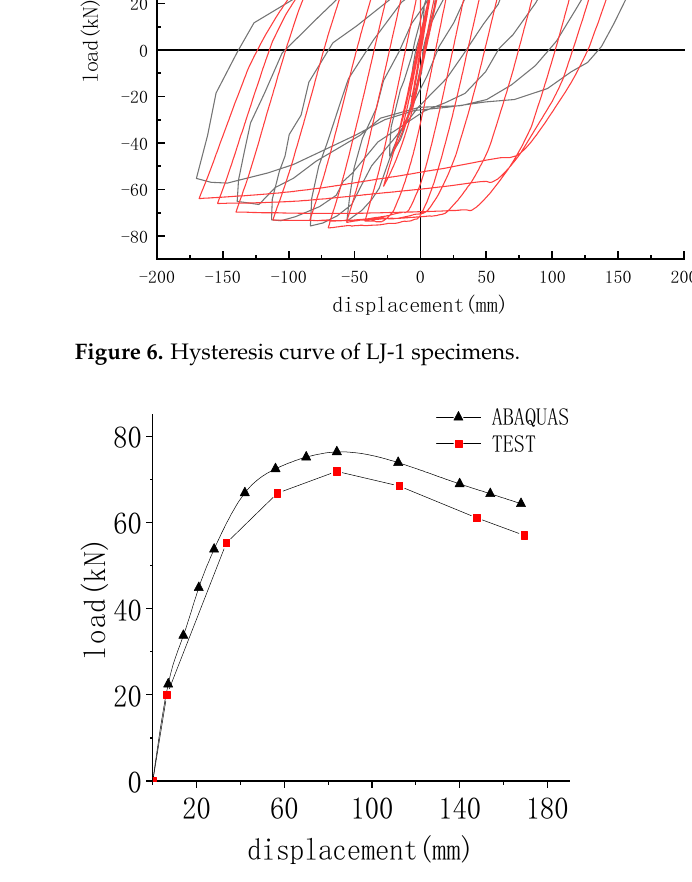
Figure 7. Comparison of skeleton curves of LJ-1 specimens. Table 2. Comparison of test and simulation parameters of LJ-1 specimen.